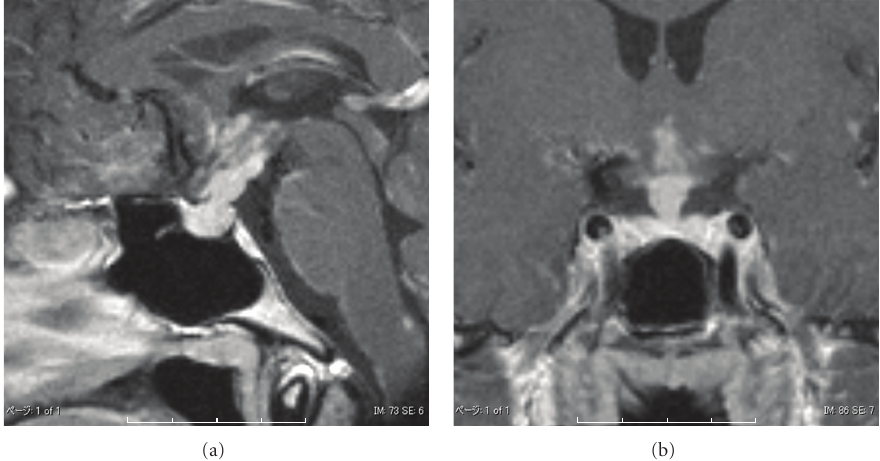
Figure 3: Hormonal provocative test results.